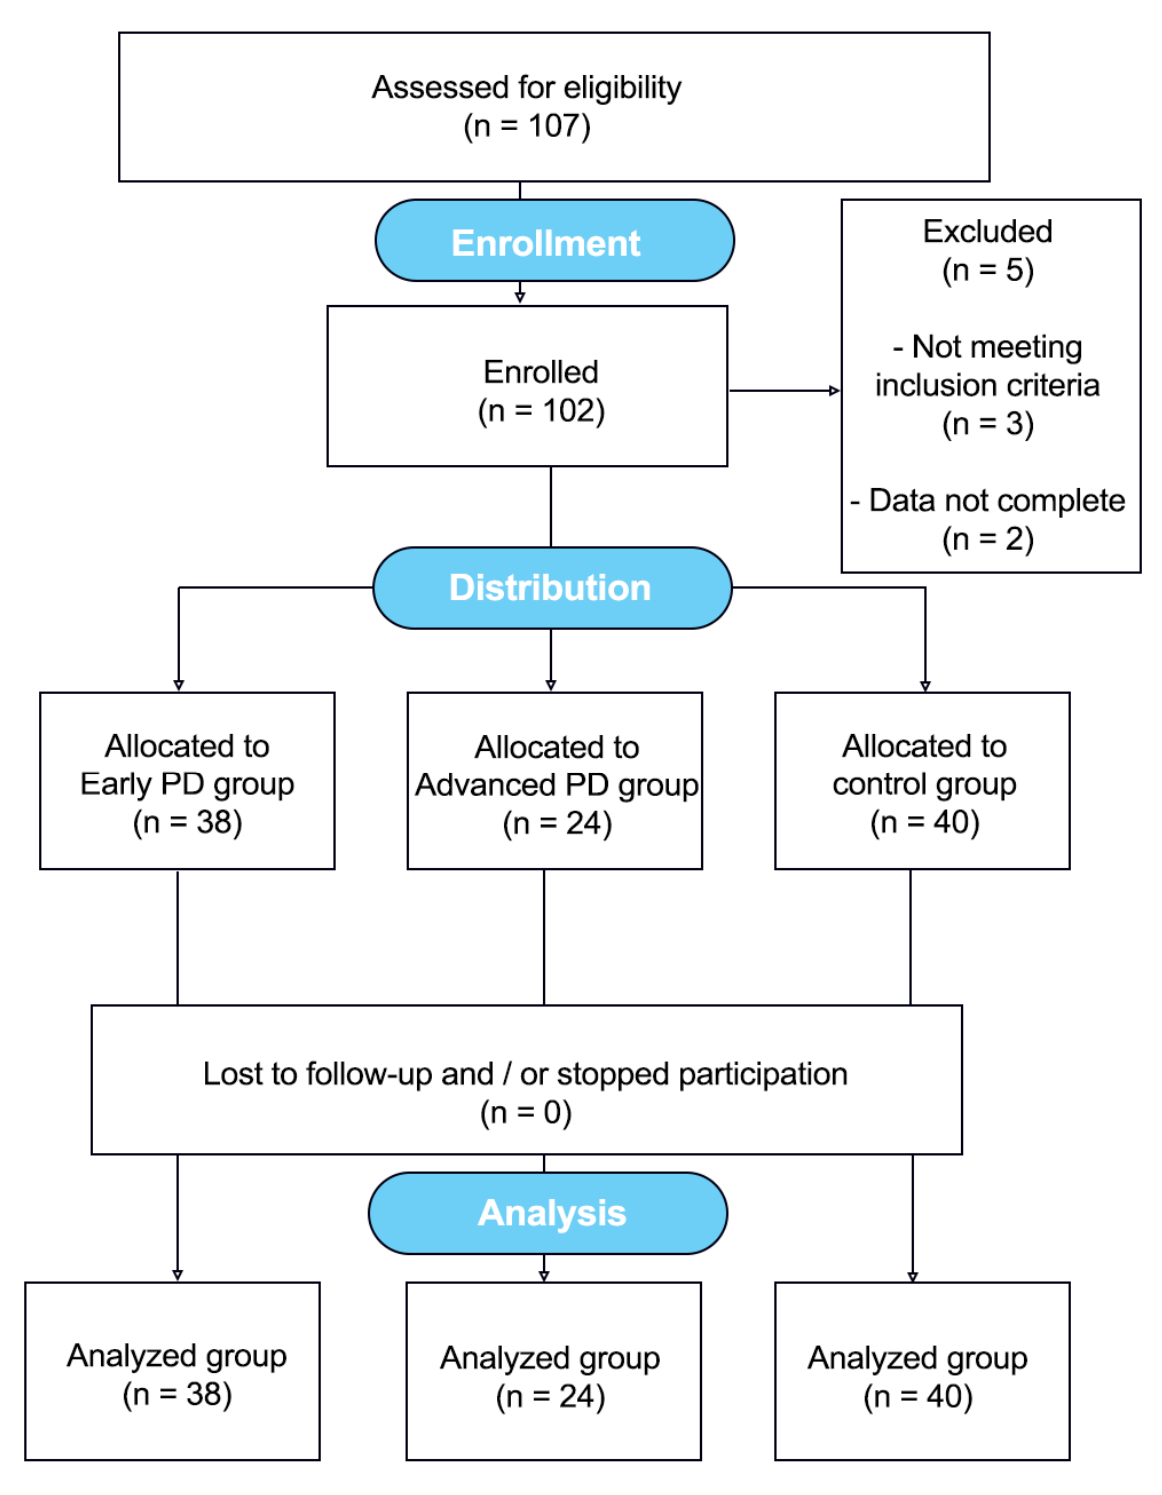
Figure 1. Flow diagram showing the course of the study [29].